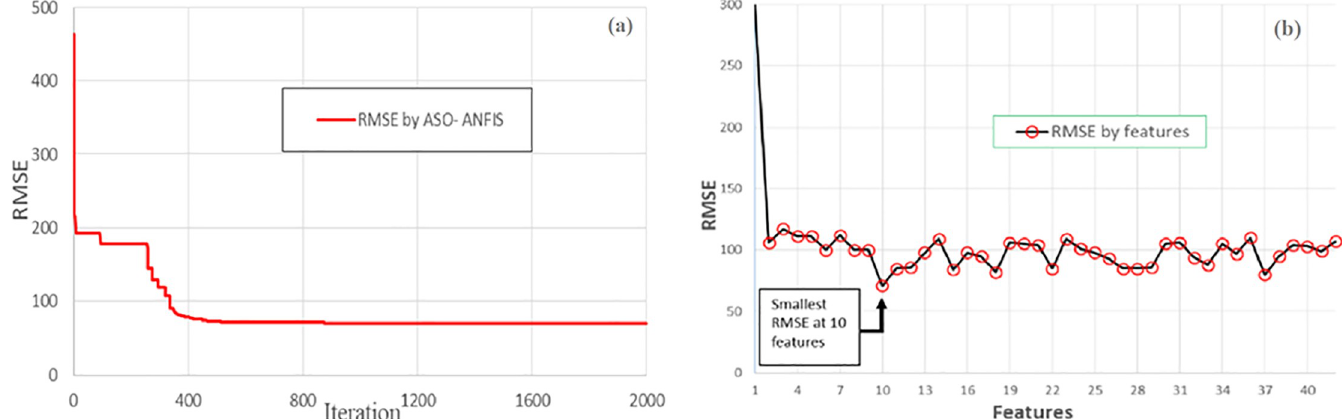
Fig 8. The performance of the ASO. a) Variation in the RMSE values of the validation plots with the use of the ASO and (b) variations in RMSE by the number of features using the ASO.